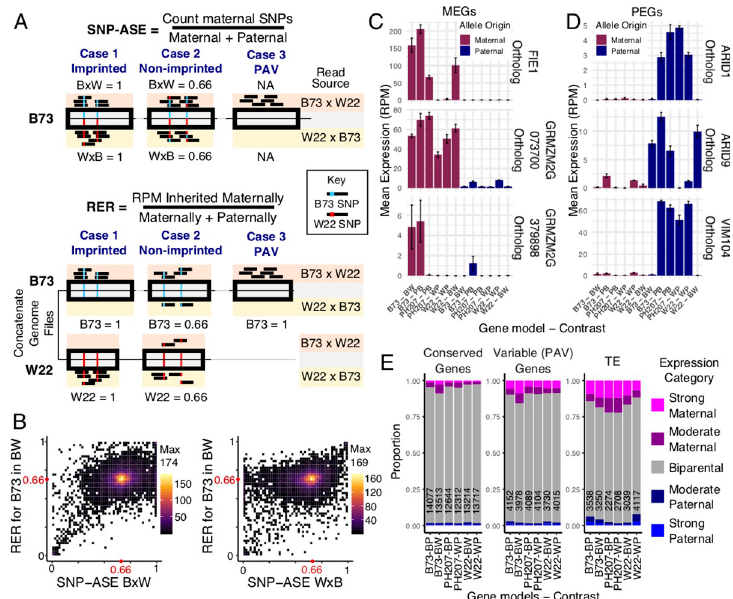
Fig 1. Assessing imprinted expression pattern in maize. A) The method for defining imprinting using SNP-ASE versus RER illustrating an example of an imprinted gene distinguishable by SNPs (Case 1), a non-imprinted gene (Case 2), and an imprinted PAV gene (Case 3). In SNP-ASE, reads mapping to a SNP-corrected reference genome are assigned to alleles based on the SNP supported. In RER, reads are assigned to a concatenated reference genome and retained at unique positions. Both methods can be used to assess imprinting for shared genes distinguished by SNPs, but only RER can assess imprinting for PAV features. B) Comparison of SNP-ASE and RER for B73 alleles assessable with at least 10 unique (RER) and informative (SNP-ASE) reads in the B73 x W22 crosses. The values plotted showi the averages across three biological replicates. SNP-ASE is calculated separately for the B73 x W22 cross (left) and reciprocal W22 x B73 cross (right), while RER is calculated with information from both reciprocals and plotted as the y-axis in both plots. The heat represents the number of genes in each pixel of the plot, and red dots indicate the expected ratios for non-imprinted expressed genes. C-D) Expression patterns of known MEGs (C) and PEGs (D) in this dataset using mapping from concatenated genomes. X-axis shows the source of the gene model and the genome contrast (where B = B73, W = W22, and P = PH207), and bars are colored based on whether the allele plotted is inherited maternally (maroon) or paternally (navy). The y-axis shows the mean expression calculated from unique mapping reads using the mapping strategy used for RER. RER values are calculated by dividing the expression when inherited maternally by the sum of expression from both directions of the cross. Error bars represent standard error, and gene IDs for the orthologs in each genome are listed in S2 Table. E) The distribution of RER values for different features across contrasts. RER cutoffs for strong maternal and strong paternal are > 0.9 and < 0.1, respectively, and cutoffs for moderate maternal and paternal are > 0.8 or < 0.2, respectively The total number of features across all expression categories are shown on each